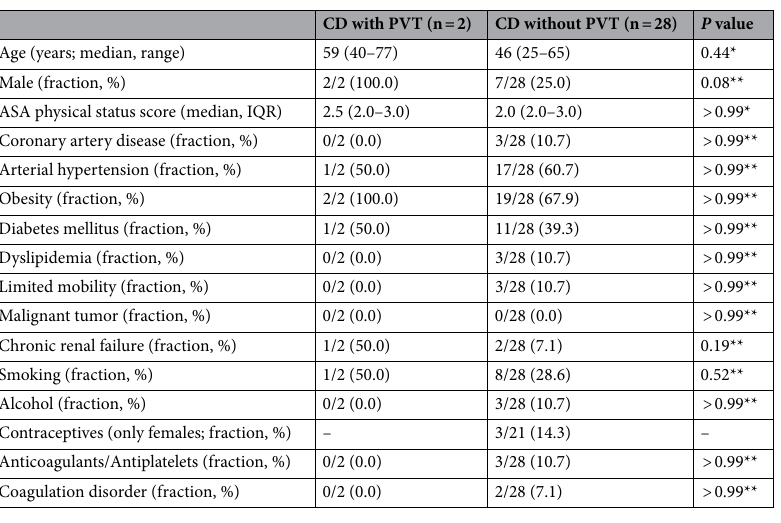
Table 1. Demographic and clinical baseline characteristics of all included Cushing’s disease (CD) patients. ASA American society of anesthesiologists, PVT perioperative venous thrombosis of the lower extremity. *Mann–Whitney test. **Fisher’s exact